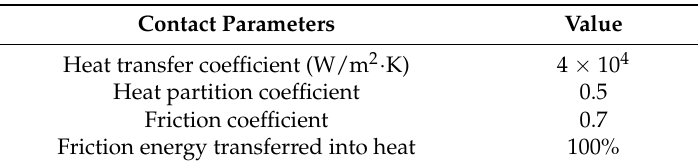
Table 1. Contact conditions for the simulation.